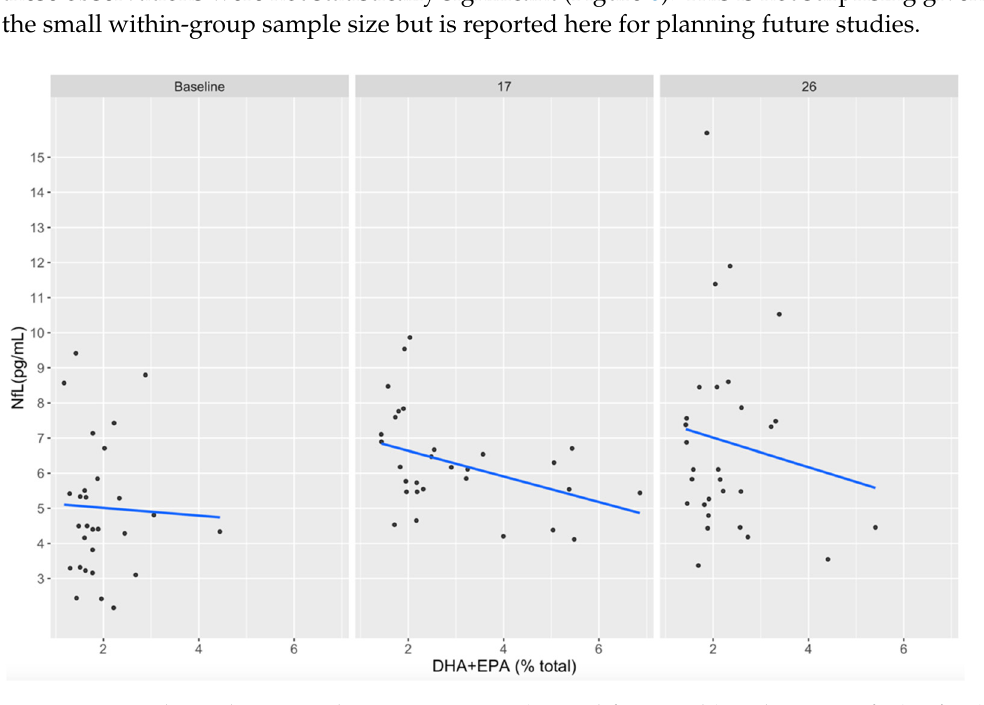
Figure 6. Correlation between plasma DHA+EPA (% total fatty acids) and serum NfL (pg/mL) concentrations in treatment and placebo groups at baseline, week 17, and week 26. DHA, docosahex- aenoic acid; EPA, eicosapentaenoic acid; NfL, neurofilament light.